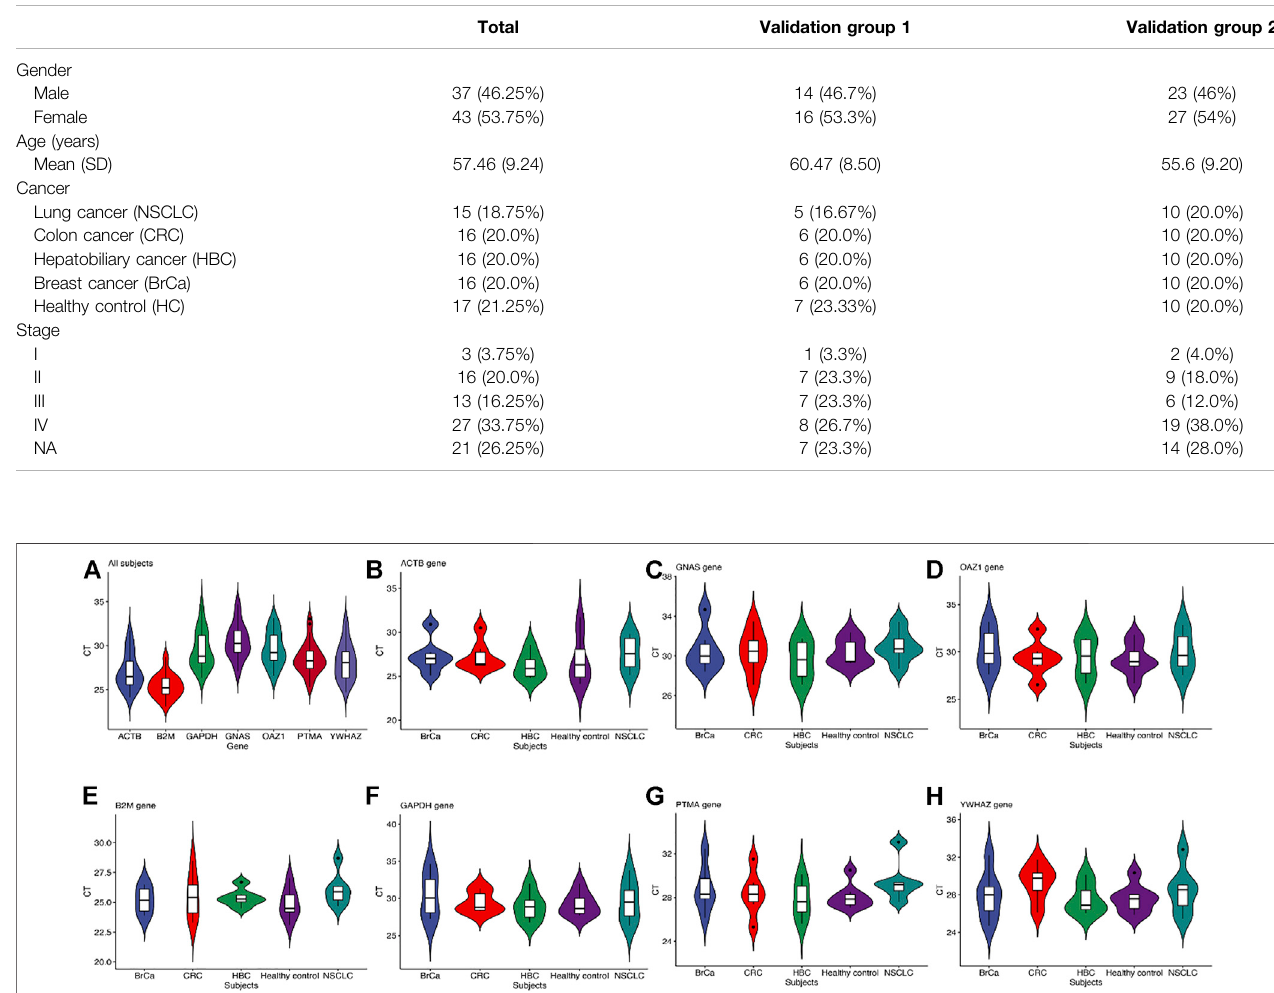
TABLE 3 | Baseline characteristics of all the enrolled subjects.